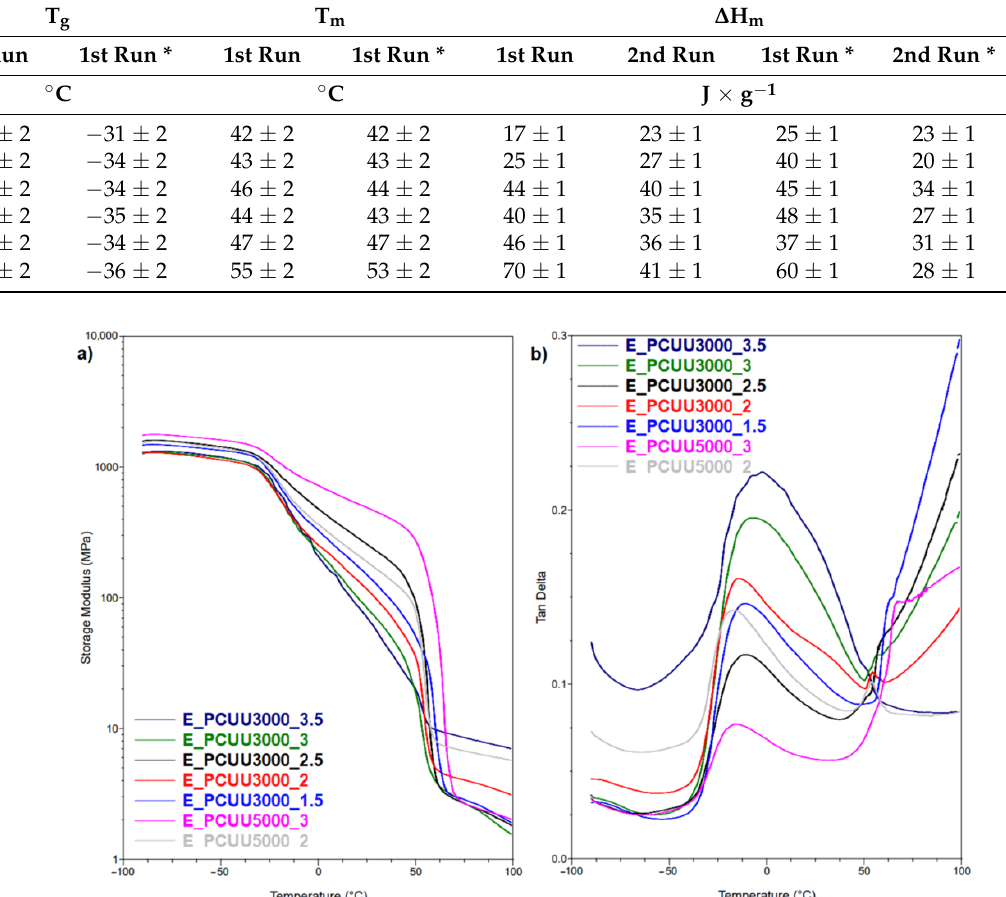
Figure 10. Reversible heat flow curves based on MDSC measurements of ( a ) E_PCUU3000_1.5; ( b ) E_PCUU3000_2.5; and ( c ) E_PCUU_3.5. The * symbol refers to sample elongated with 100% strain (1st run *) and the second heating run of the previously elongated sample after its return to the primary shape (2nd run *).